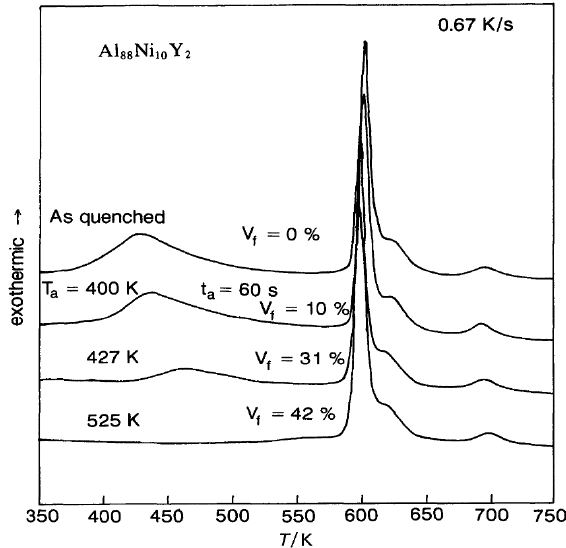
Figure 1. DSC curves measured at 0.67 K/s of an Al 88 Ni 10 Y 2 amorphous alloy aged for 60 s at different T a . Reprinted from ref. [42], Figure